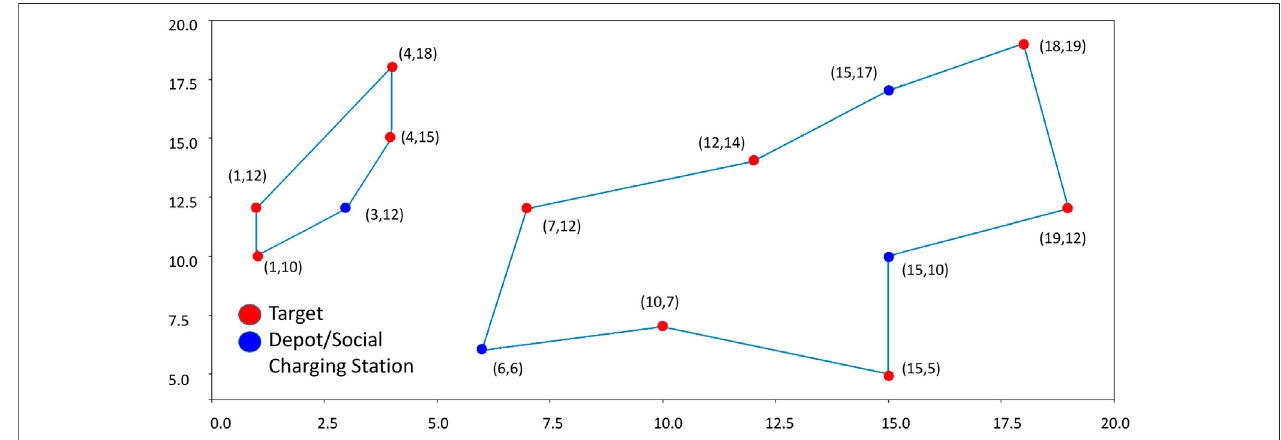
FIGURE 6 | Example of algorithm output. Red circles correspond to targets to be visited by drones; blue circles correspond to Depots/Social Charging